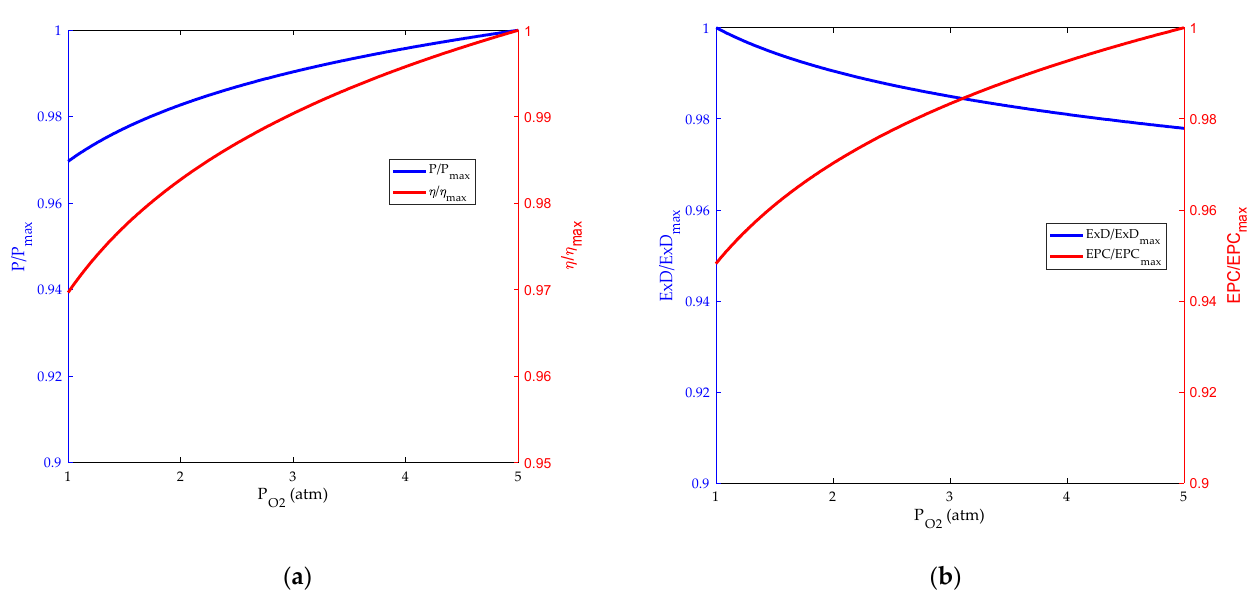
Figure 8. Influence of oxygen pressure. ( a ) Power density and energy efficiency; ( b ) exergy destruction rate and exergetic performance coefficient.